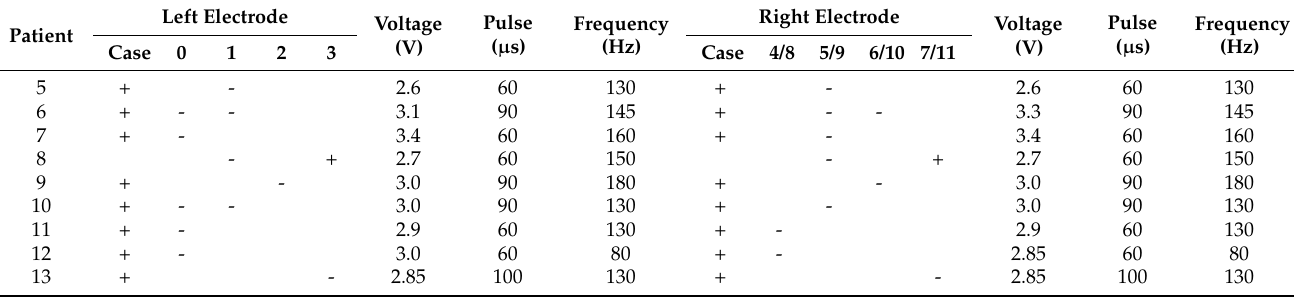
Table 4. Stimulation parameters at the final